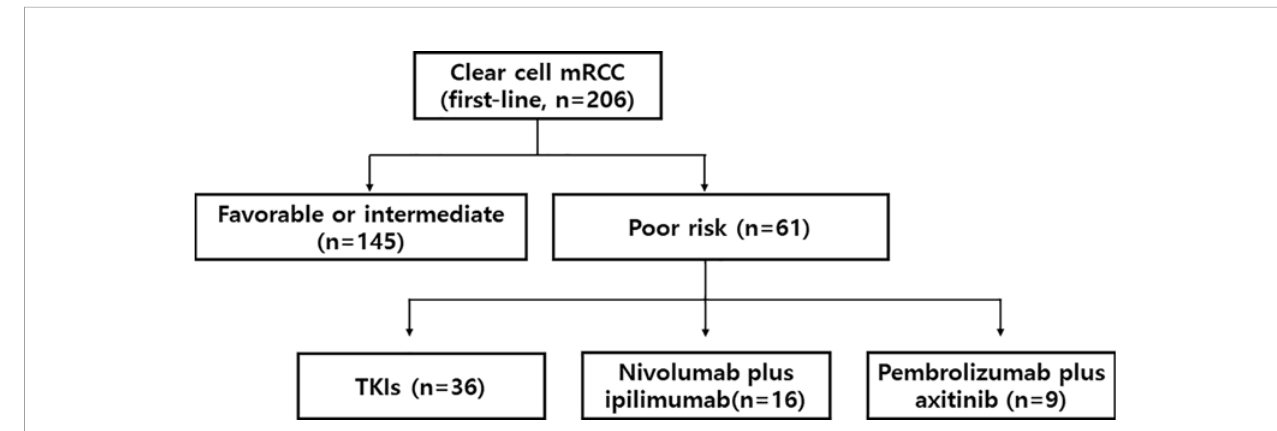
FIGURE 1 | Study fl ow. mRCC denotes metastatic renal cell carcinoma. TKI denotes tyrosine kinase